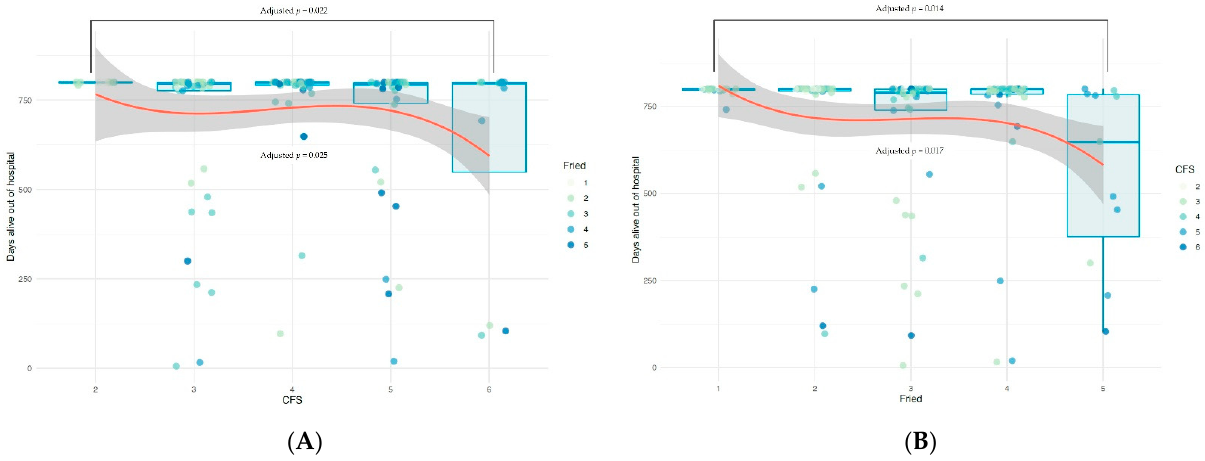
Figure 3. Relationship between primary endpoint (DAOH) and frailty scales (( A ): Fried scale, ( B ): Clinical Frailty Scale [CFS]) considered as categorical (boxplots) and continuous (red line representing grade 3 factorial polynomial adjustment). P values adjusted by multivariate GLMs including the two frailty scales, relevant clinical variables and those with p < 0.1 in the univariate analyses.